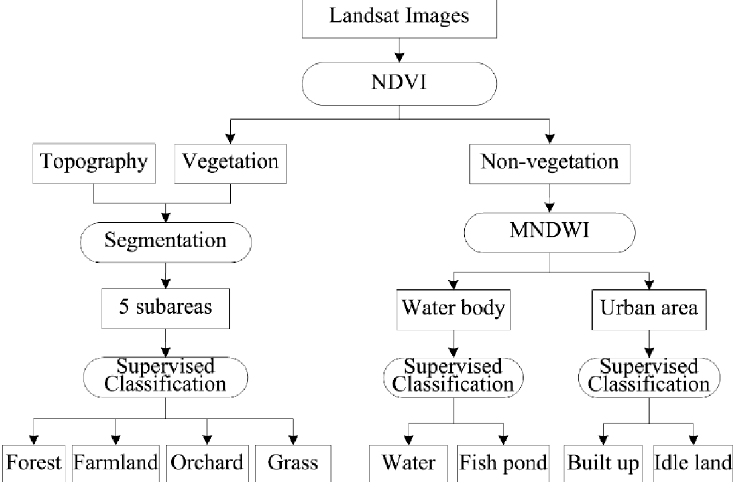
Figure 2. Procedure for land use